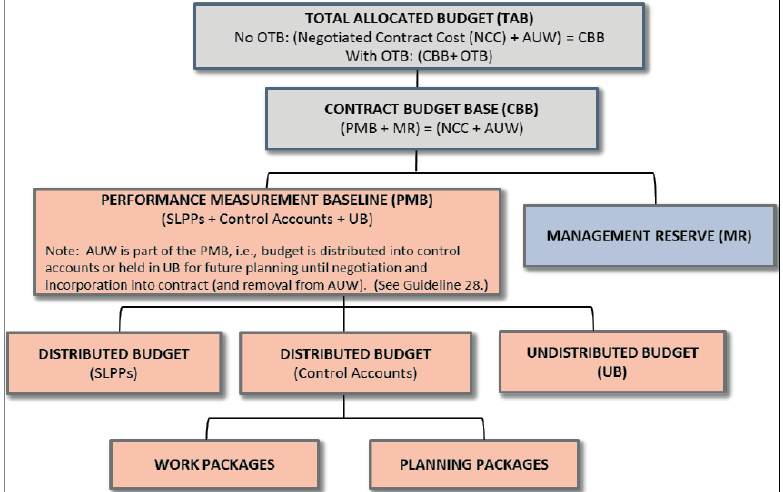
Fig. 12a. Budget hierarchy and summarization (DOD, 2015: 41).